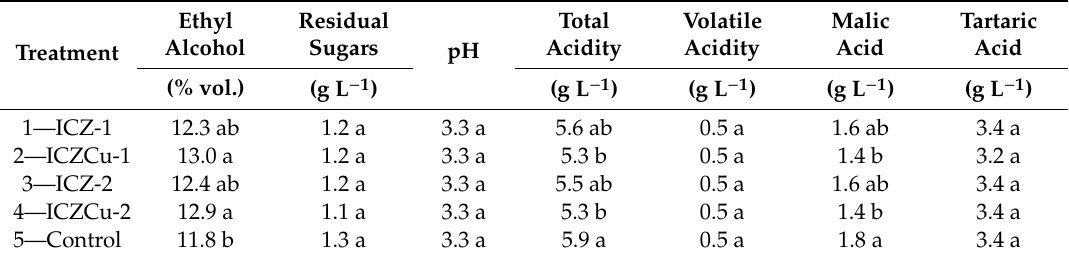
Table 6. Chemical composition of the wines obtained from Trebbiano d’Abruzzo vines of Controguerra vineyard treated in 2019 with Italian chabasite-rich zeolitite and Italian copper chabasite-rich zeolitite (ICZ and ICZCu), after eight months of